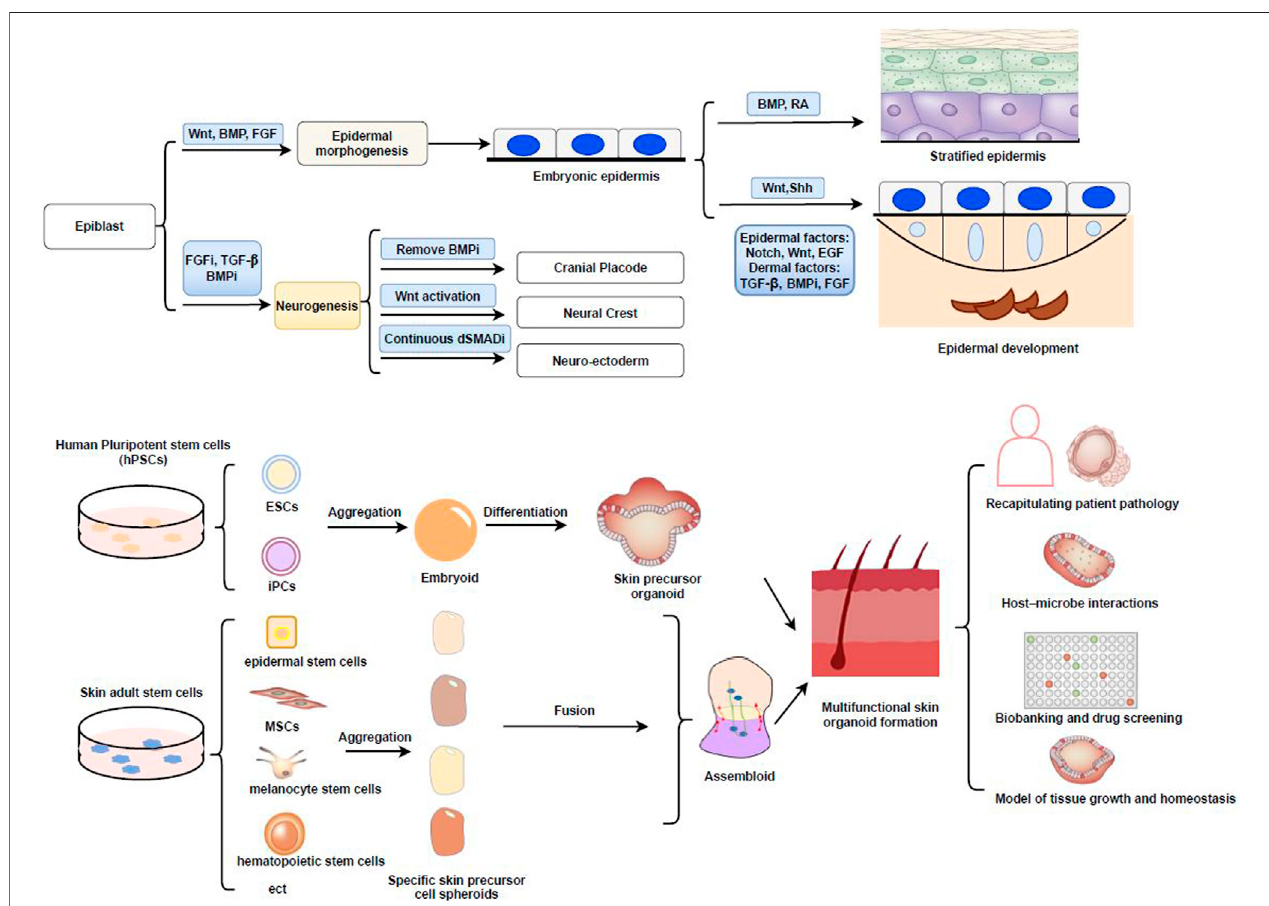
FIGURE1|(A) Earlysignalingofskindevelopment.Wntsignalingblockstheabilityofearlyectodermalprogenitorcells,allowingthemtorespondtoBMPsignaling and adopt an epidermal fate. Representation of the border model and important signaling pathways such as mall molecules termed as dual SMAD inhibition (dSMADi) thatinhibittheBMPandTGF β signalingpathways,respectivelyandin fl uenceparticularcellfatesinneurogenesisaswellasCP,NC,NE.WhileWnt/Shhactivatingsignals producethehairplacodeandadditionaldermalmessagesfurtherinstructtheplacodestomakethehairfollicle. (B) Schematicillustrationofskinorganoidformation and its application.This fi gure summarizes how integration ofskin organoid technologywithPSC/ASC approaches (includingEBformation andfusionassembloids with different skin precursor cells) allowed the understanding of various applications in skin diseases. Cranial placode, CP; dual SMAD inhibition, dSMADi; Embryoid-body, EB; Neural crest, NC; Neuroectoderm, NE; Retinoic acid, RA.